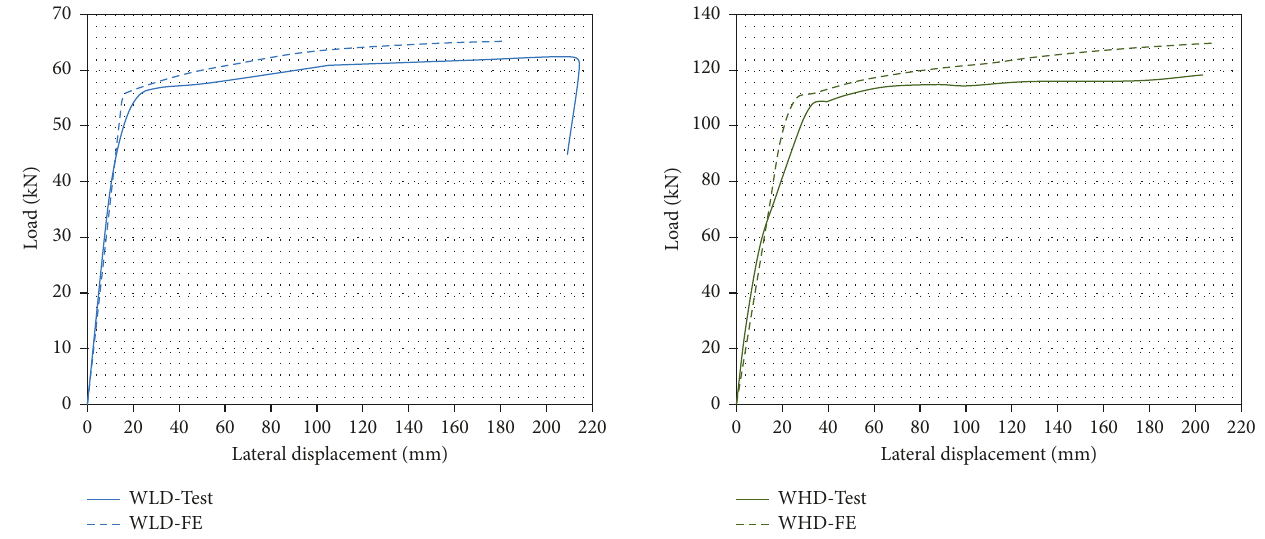
Figure 12: Load-deflection verification curve of test versus FE (specimen